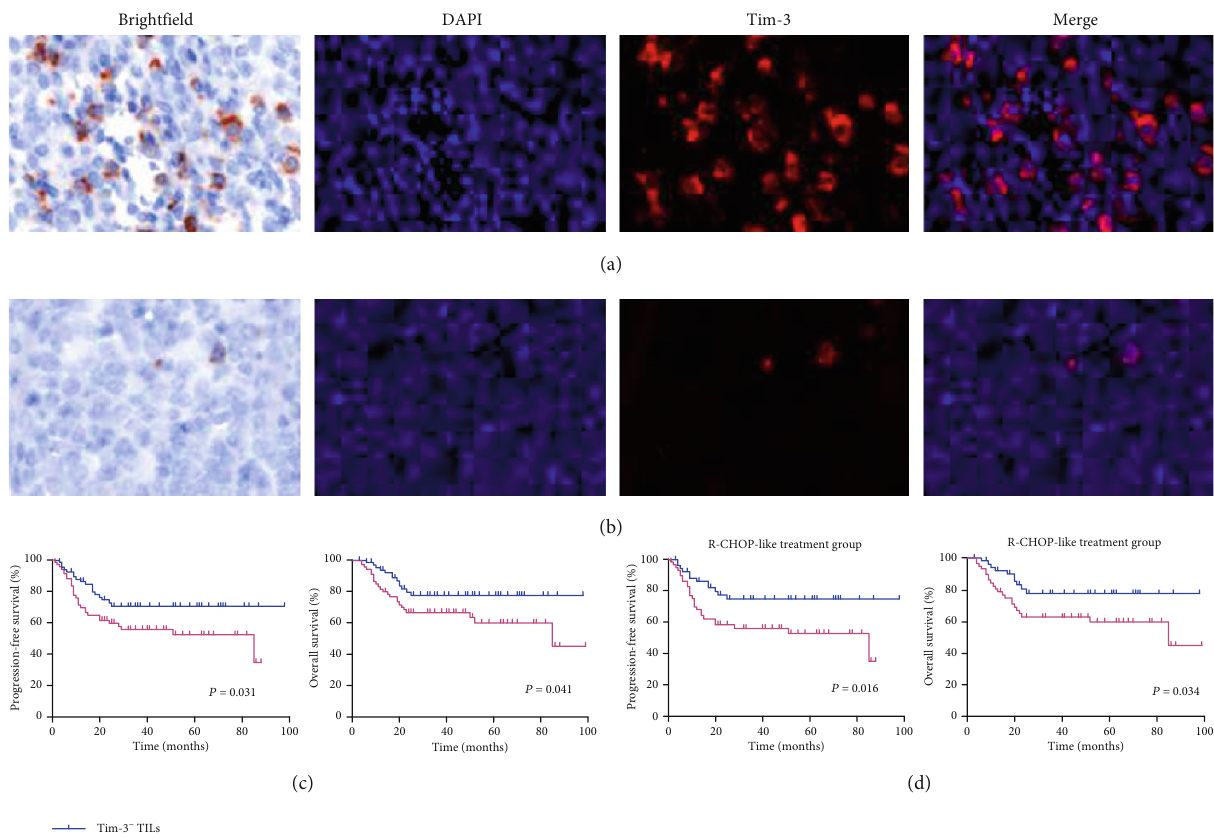
Figure 3: Expression of Tim-3 on tumor-in fi ltrating lymphocytes (TILs) and survival of patients with DLBCL: (a, b) Representative images of bright fi eld and fl uorescence microscopy for the expression of Tim-3 on TILs. (c) Kaplan-Meier curves for progression-free survival (PFS) and overall survival (OS) in DLBCL patients with Tim-3 + TILs and Tim-3 - TILs ( n = 134 ). (d) Kaplan-Meier curves for PFS and OS in DLBCL patients with Tim-3 + TILs and Tim-3 - TILs in the R-CHOP-like treatment subgroup ( n = 109 ). DAPI (blue) and Tim-3 (red) staining. Scans were imaged at 200x magni fi cation. Log-rank test was used to determine the signi fi cance of comparison between two